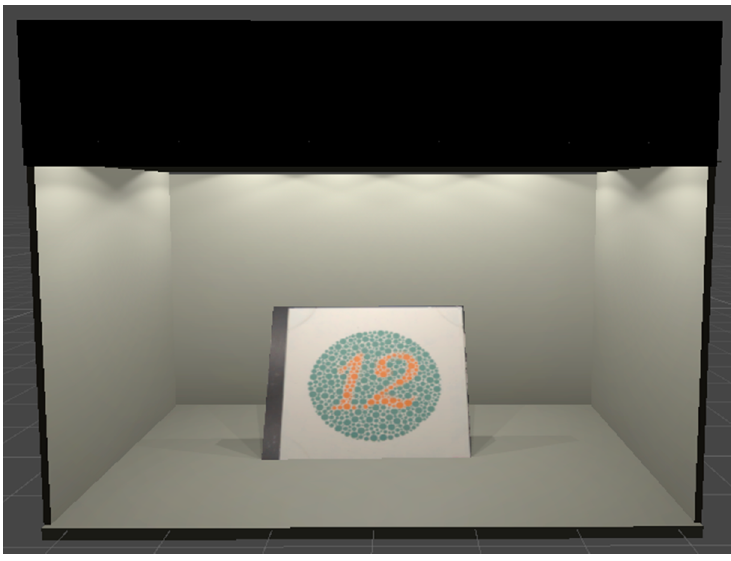
Figure 9. Visual appearance of the virtual lightbooth with the Ishihara test plate.